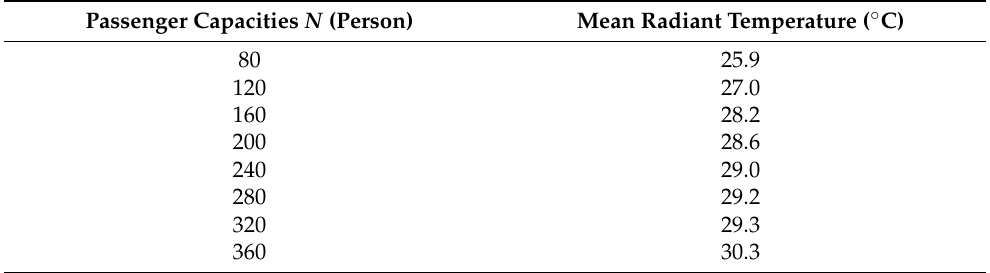
Table 6. The average radiant temperature of the human body under different passenger